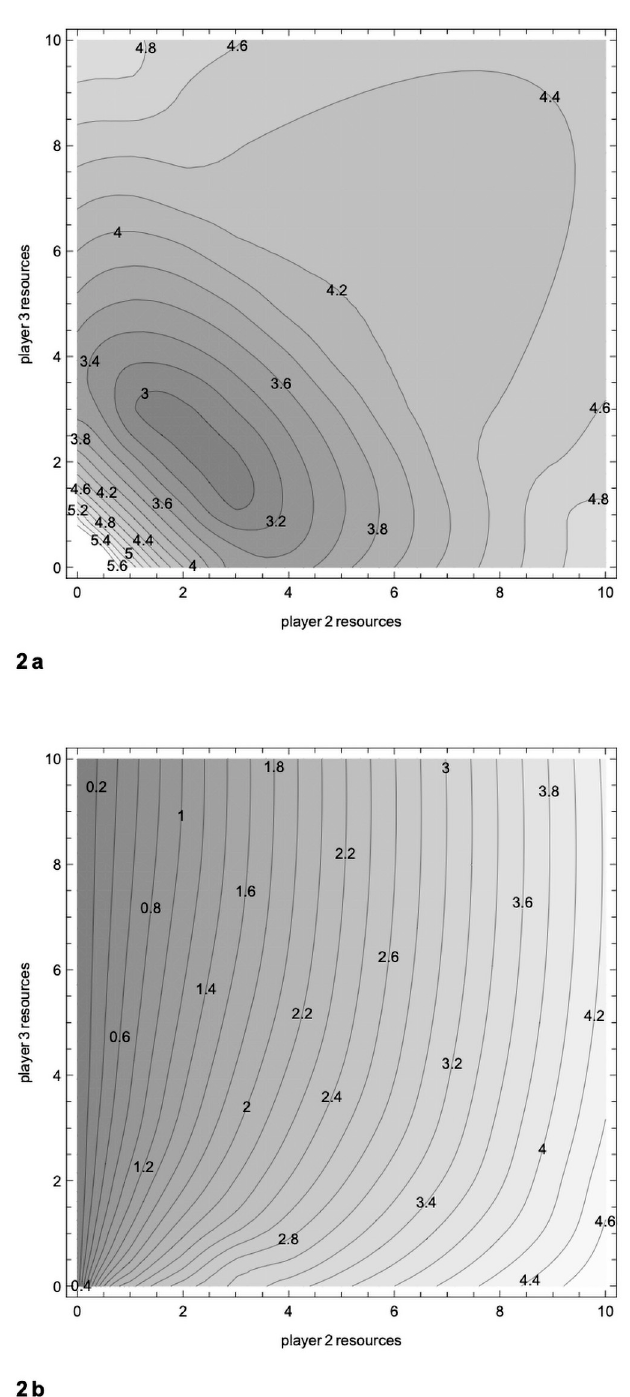
Fig 2. The paradox of power with 3 players. a. Income (contour lines) for player 1, resources = 10, facing players 2 and 3, varying resources. Player 1’s income is 10 when resources are 0 and 0 for players 2 and 3. His income is lowest, 2.95, when resources are 2.33 and 2.33 for players 2 and 3, who are putting everything into fighting. His income is 4.44 when resources = 10 for all players. Bottom edge corresponds to upper curve in Fig 1. b. Income (contour lines) for player 2, varying resources, facing player 1, resources = 10, and player 3, varying resources. Bottom edge corresponds to lower curve in Fig 1.